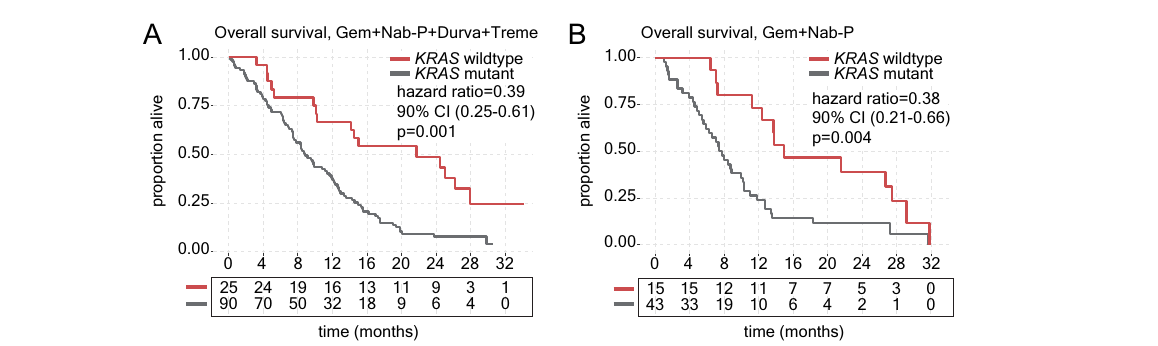
Fig. 2 | Somatic mutation landscape of mPDAC detected using liquid biopsy (ctDNA)sequencing atbaseline.A Oncoprint depicting most frequently mutated genes detected by baseline ctDNA sequencing in the cohort of 173 patients with mPDAC. Upper bars indicate blood tumor mutation burden (TMB; mut/Mb) levels and are colored based on microsatellite instability (red) or stable (grey) status.